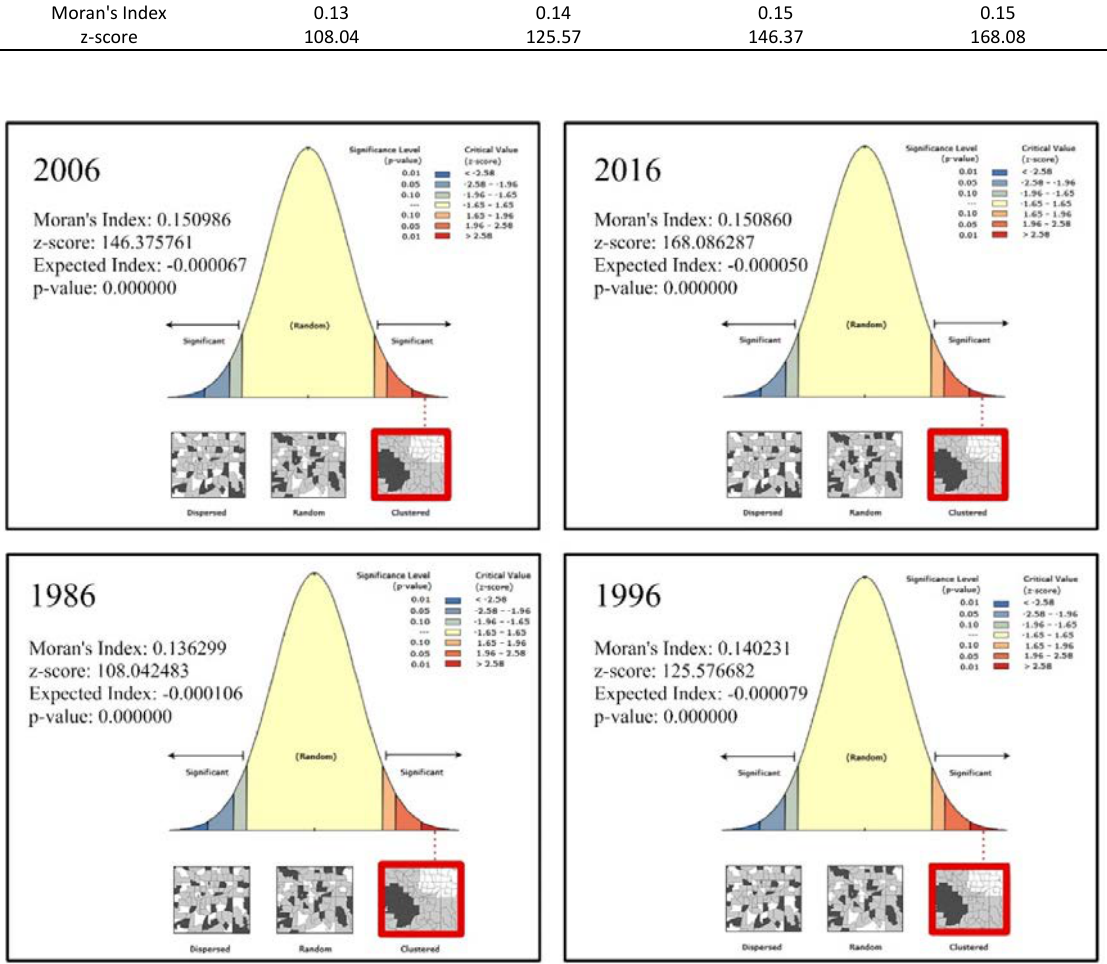
Fig. 2: Spatial autocorrelation reports